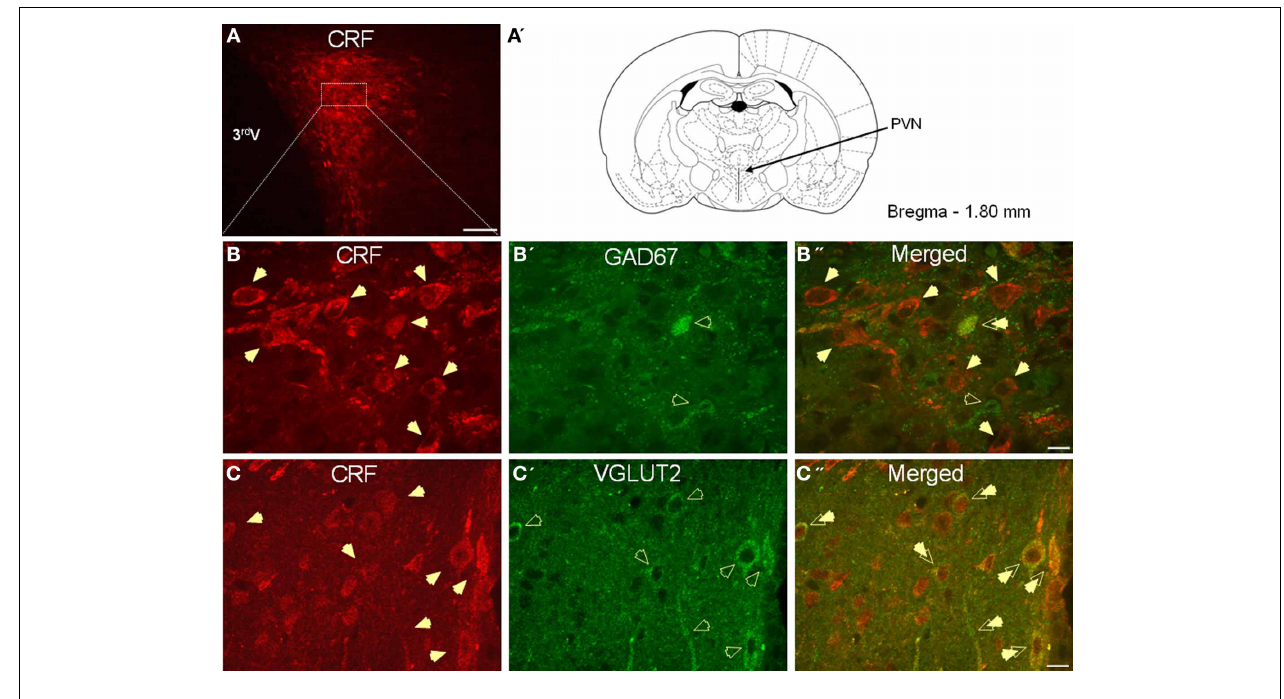
FIGURE 1 | (A) Photomicrograph showing high somatodendritic immunoreactivity of CRF in the parvocellular neurons of the PVN (magnification 10 × , scale bar 10 μ , 3rd V- third ventricle). (B–B”): Photomicrographsshowing non-overlapping somatodendritic immunoreactivity of CRF ( B, red, closed arrows) and GAD67 ( B’, green, open